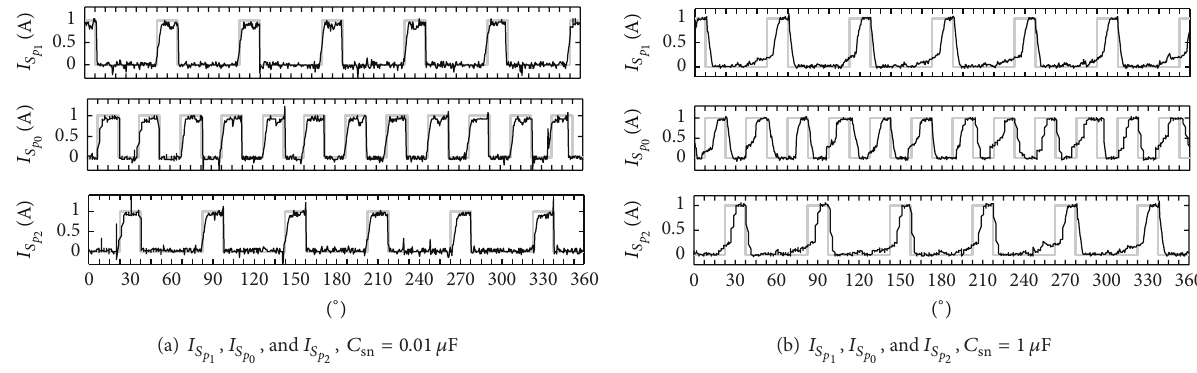
Figure 24: Experimental currents 𝐼 𝑆